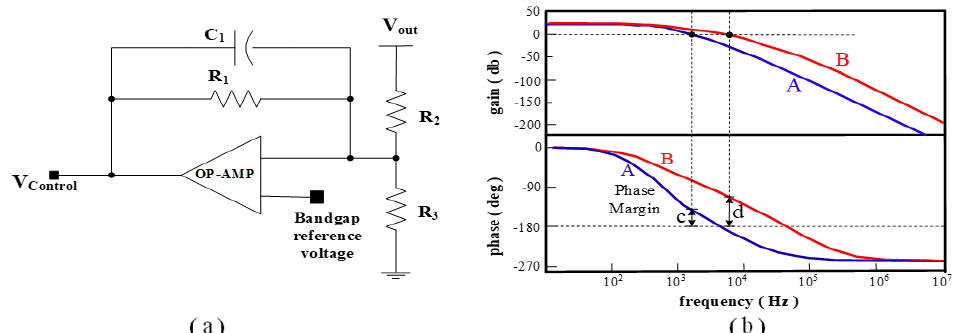
Figure 3. Proposed OTA circuit: ( a ) schematic of compensator with operational amplifier; ( b ) fre- quency response of the loop gain (A: without pole–zero optimization, B: with pole–zero optimzation). The stability and frequency response are determined directly by the pole.